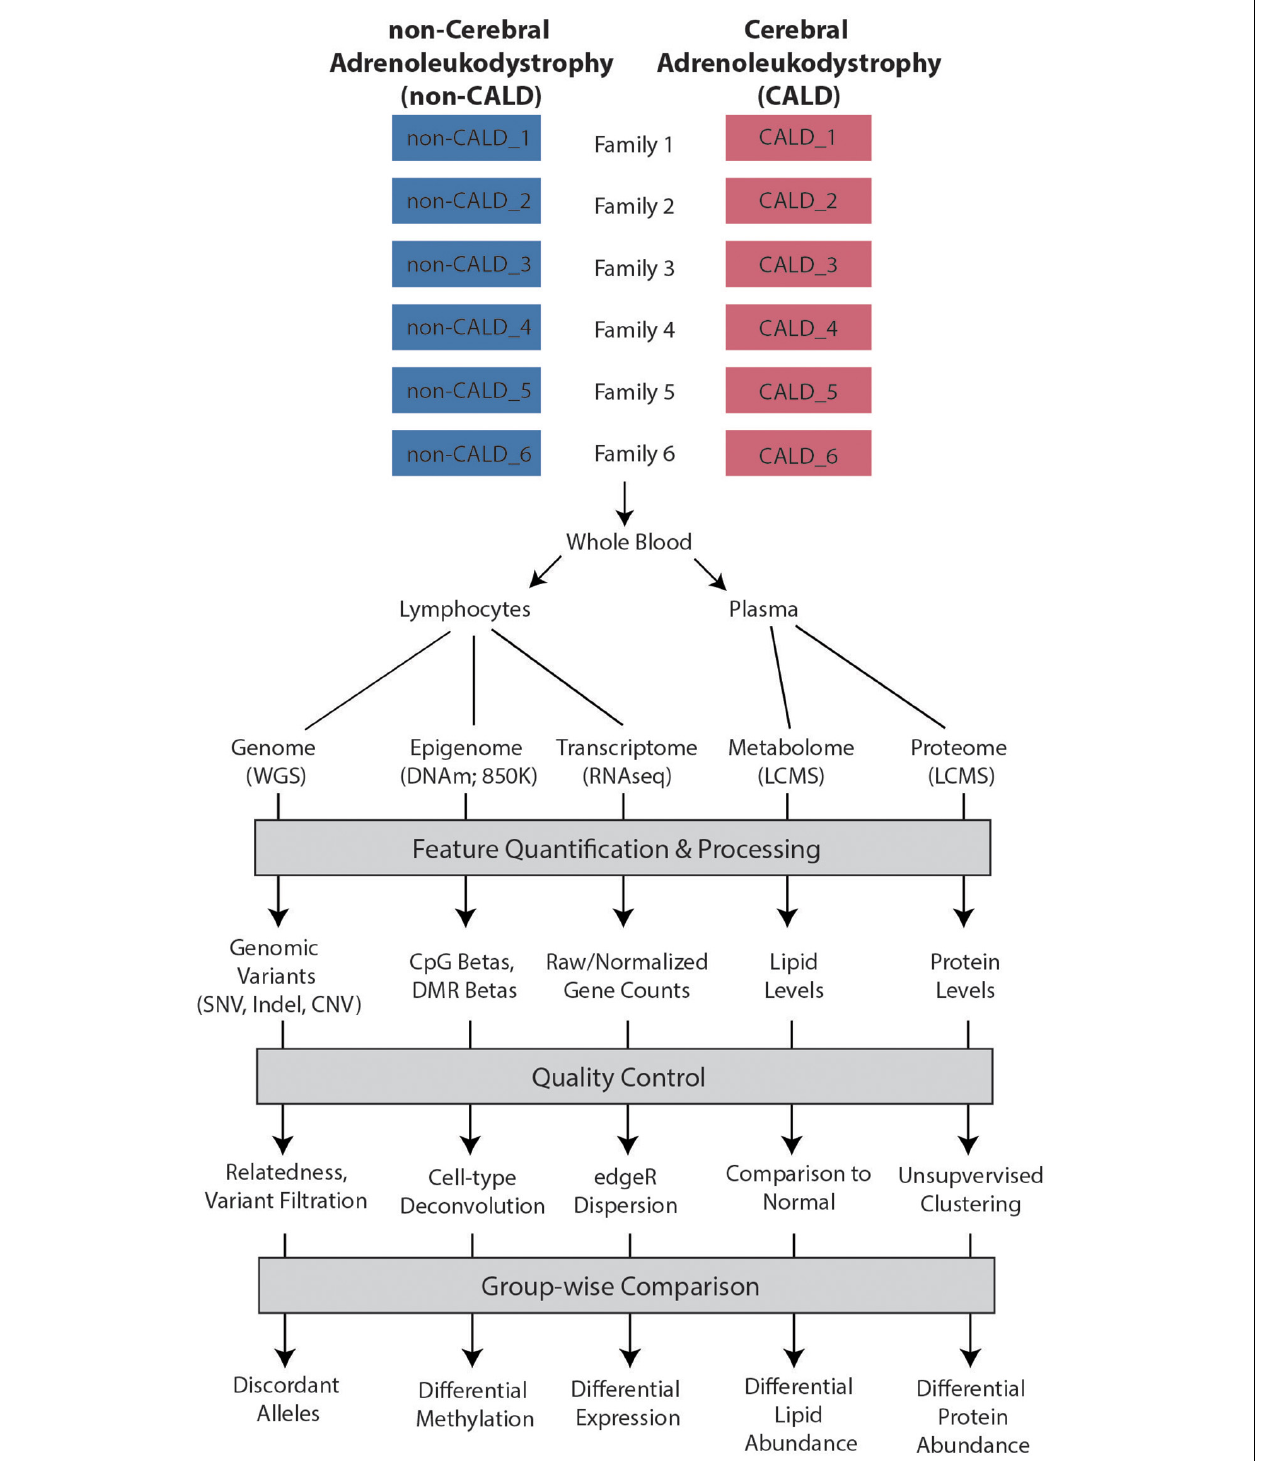
FIGURE 1 | Project overview. An overview of the data and processes involved in the project including samples from two brothers across unrelated families, blood isolated into lymphocytes and plasma, and then profiling with five omics technologies including WGS for the genome, DNA methylation (DNAm) via the 850K EPIC microarray, transcriptome profiling with RNA sequencing (RNA-seq), metabolome profiling with liquid chromatography mass spectrometry (LCMS), and protein profiling with LCMS. These data are then taken through feature quantification/processing, quality control metrics, and group-wise comparison through univariate